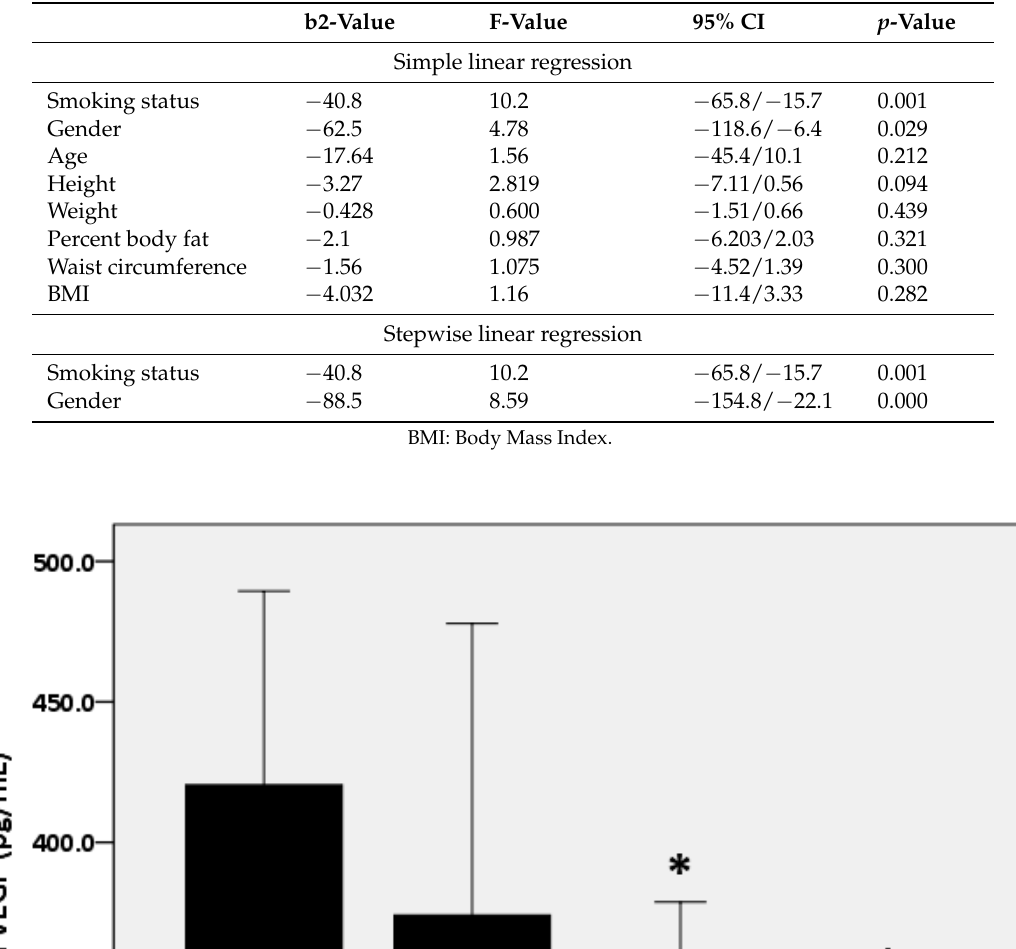
Table 2. Linear regression for vascular epithelium growth factor (VEGF) predictors.